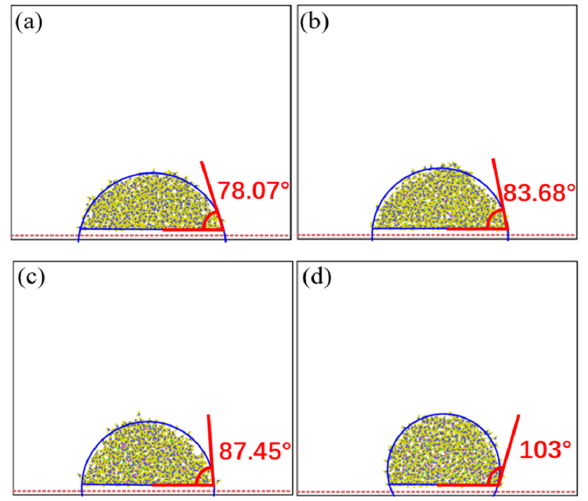
Figure 8. Contact angle of physiological saline under different concentrations of NaCl, ( a ) 3%, ( b ) 6%, ( c ) 13.2%, and ( d )